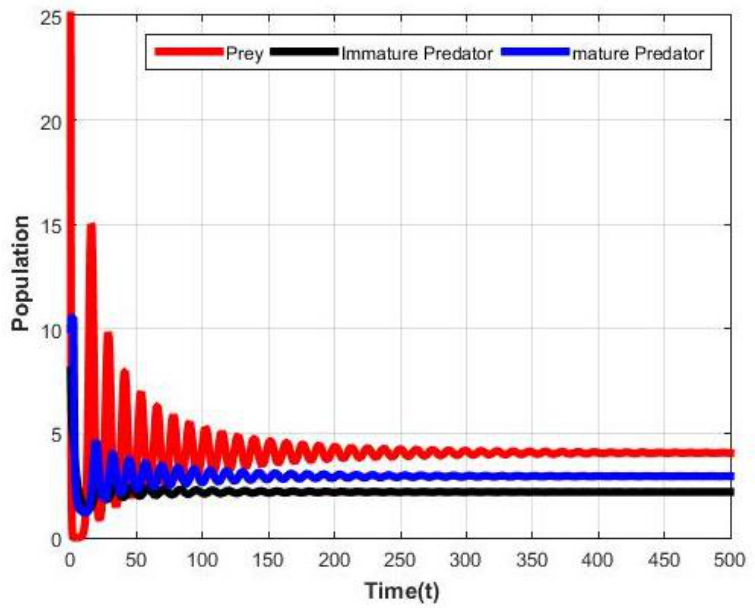
Figure 9. Population graph for 𝛾 =